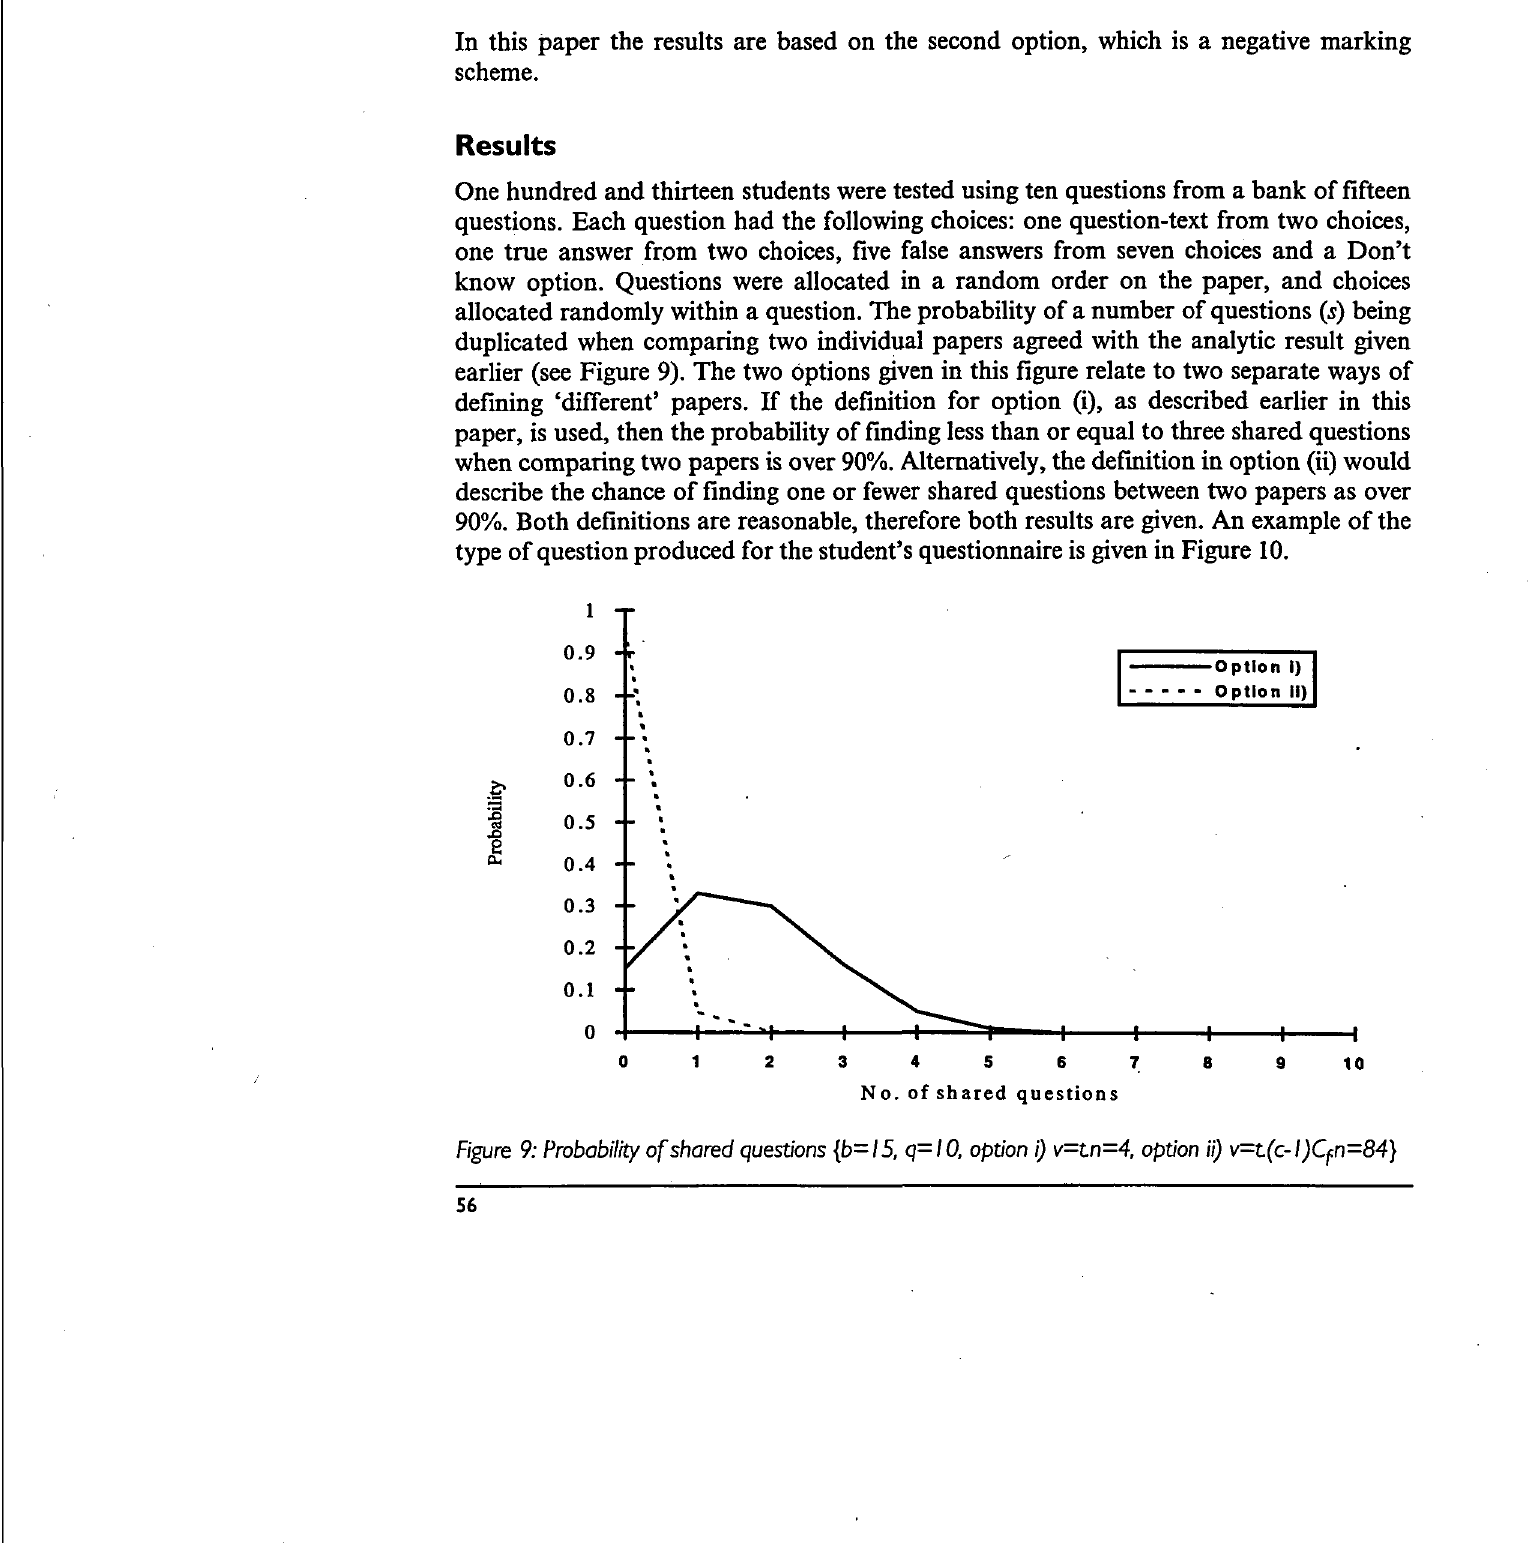
Figure 9: Probability of shared questions {b=l5, q=IO, option i) v=tn=4, option ii)